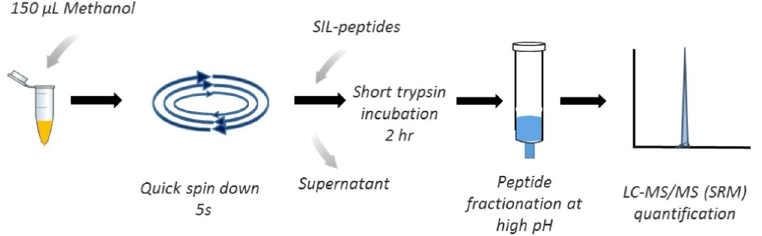
Figure 1. Simplified protocol for sample preparation prior to LC-MS/MS analysis. Figure 1 was prepared for the manuscript entitled “A simple and rapid LC-MS/MS method for therapeutic drug monitoring of cetuximab: proof of concept study in head-and-neck cancer patients”. All images were drawn by co-authors at CEA, France.